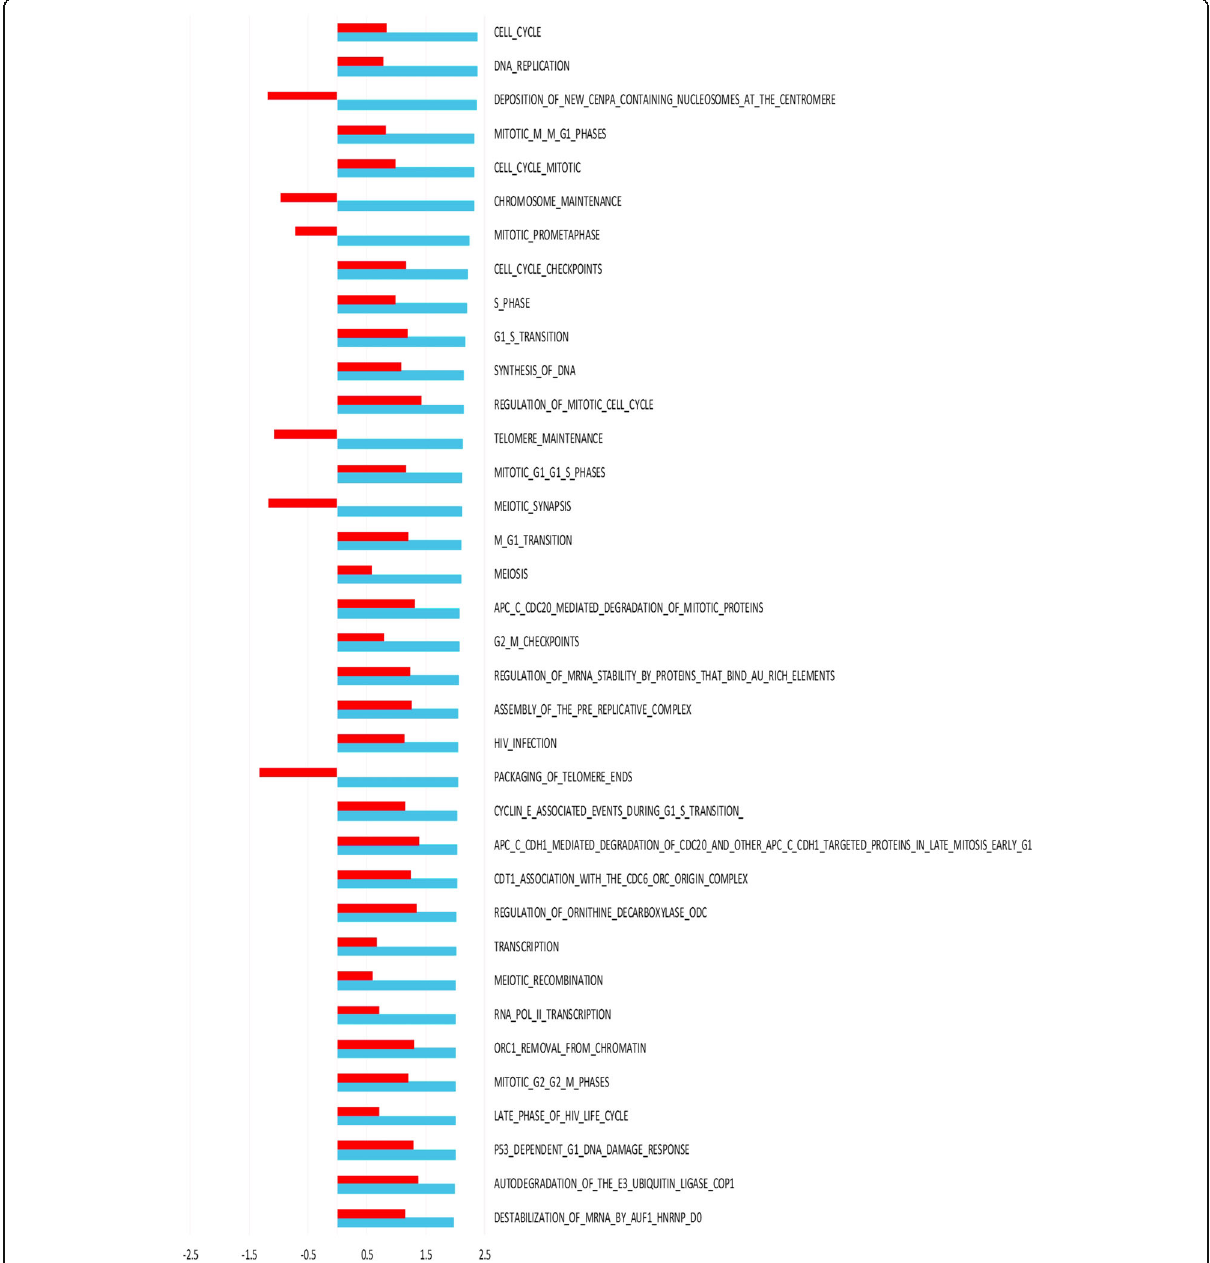
Fig. 5 Comparison of GSEA on effect of warm and cold ischemia on tumor tissue. NES depicted in blue for all Reactome pathways significantly altered in tumor tissue collected post-surgery compared to pre-surgery (warm ischemia). To illustrate concordance with previously published data by Aktas et al. (2014) NES from tumor tissue subjected to 40 min cold ischemia post surgery are represented by red bars. One pathway had a nominal p -value < 0.05 in the dataset from Aktas: